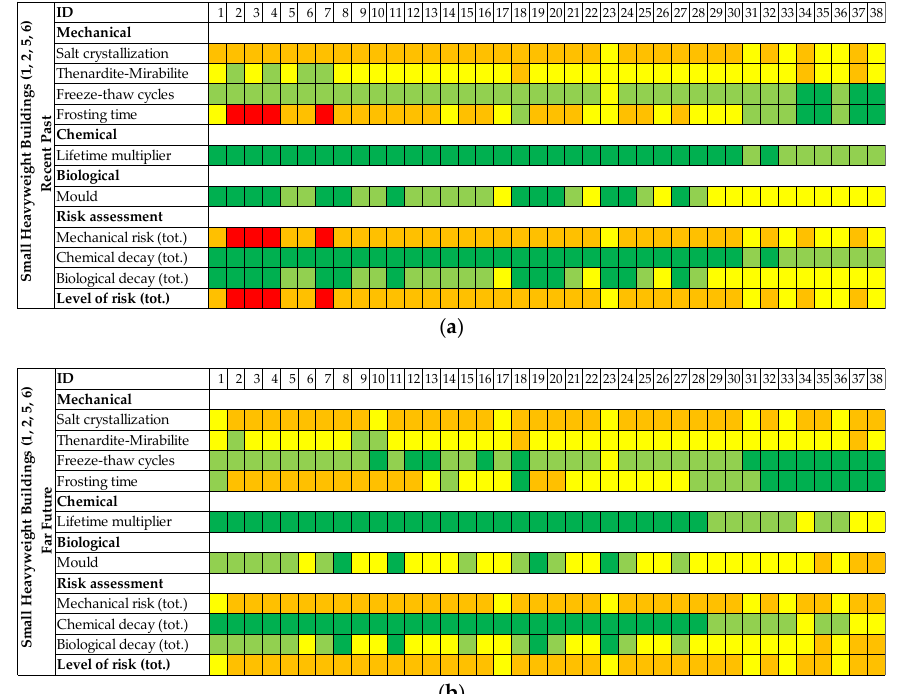
Figure 5. Risk assessment matrix of the deterioration of small heavyweight buildings in: ( a ) Recent Past (1961–1990); ( b ) Far Future (2071–2100).